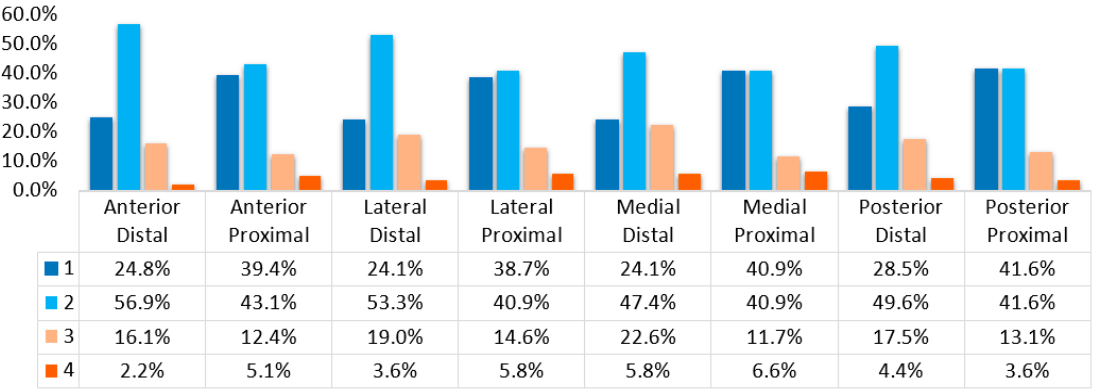
Figure 2. Distribution of corrosion score levels across the entire eight stem taper zones of the 137 retrieved implants.